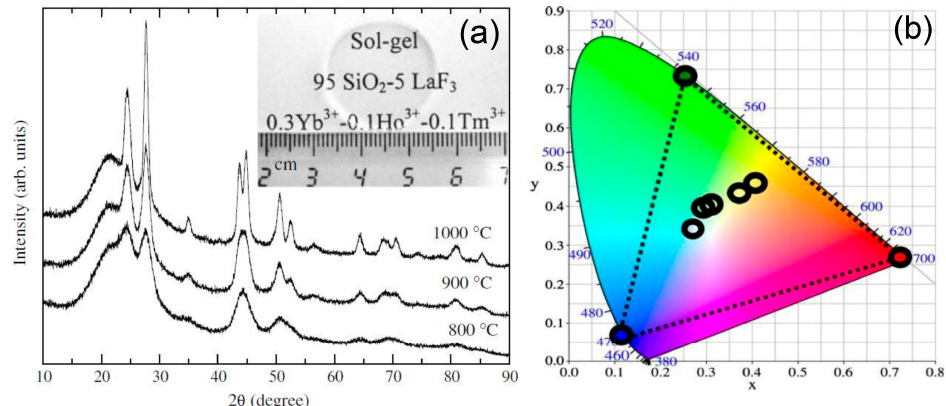
Figure 3. ( a ) XRD patterns of 95SiO 2 -5LaF 3 GCs at different temperatures and ( b ) CIR standard chromaticity showing the up-conversion emission for GCs co-doped with 0.3Yb 3+ , 0.1Ho 3+ and 0.1 Tm 3+ [53].